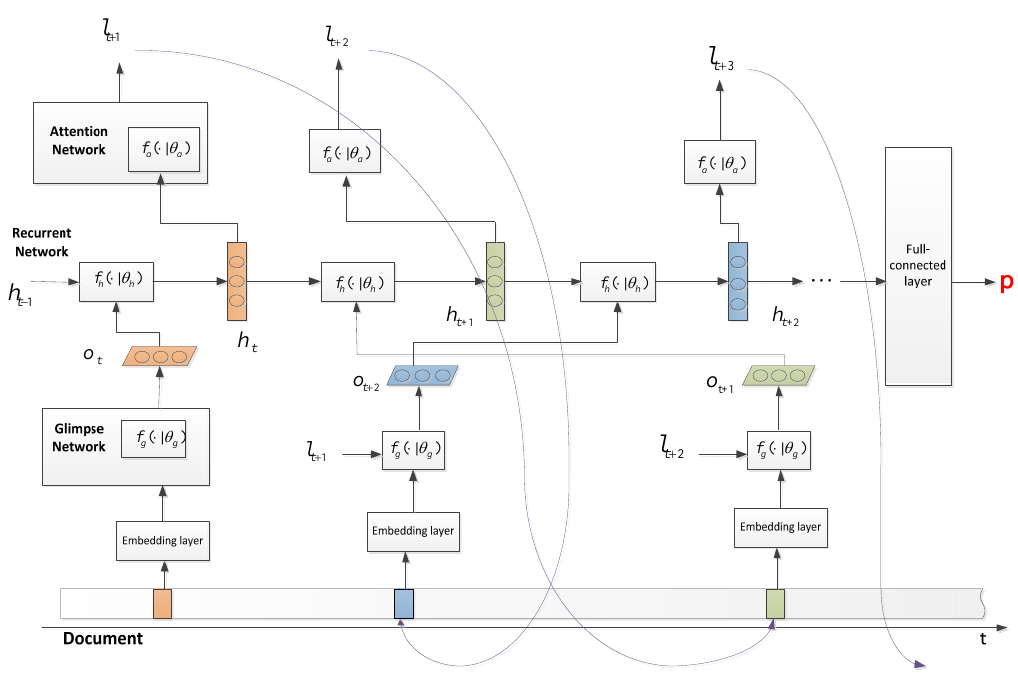
Figure 4. Model C NN_RAM_Agg architecture. RAM—recurrent attention model. Figure 4. Model CNN_RAM_Agg architecture. RAM—recurrent attention